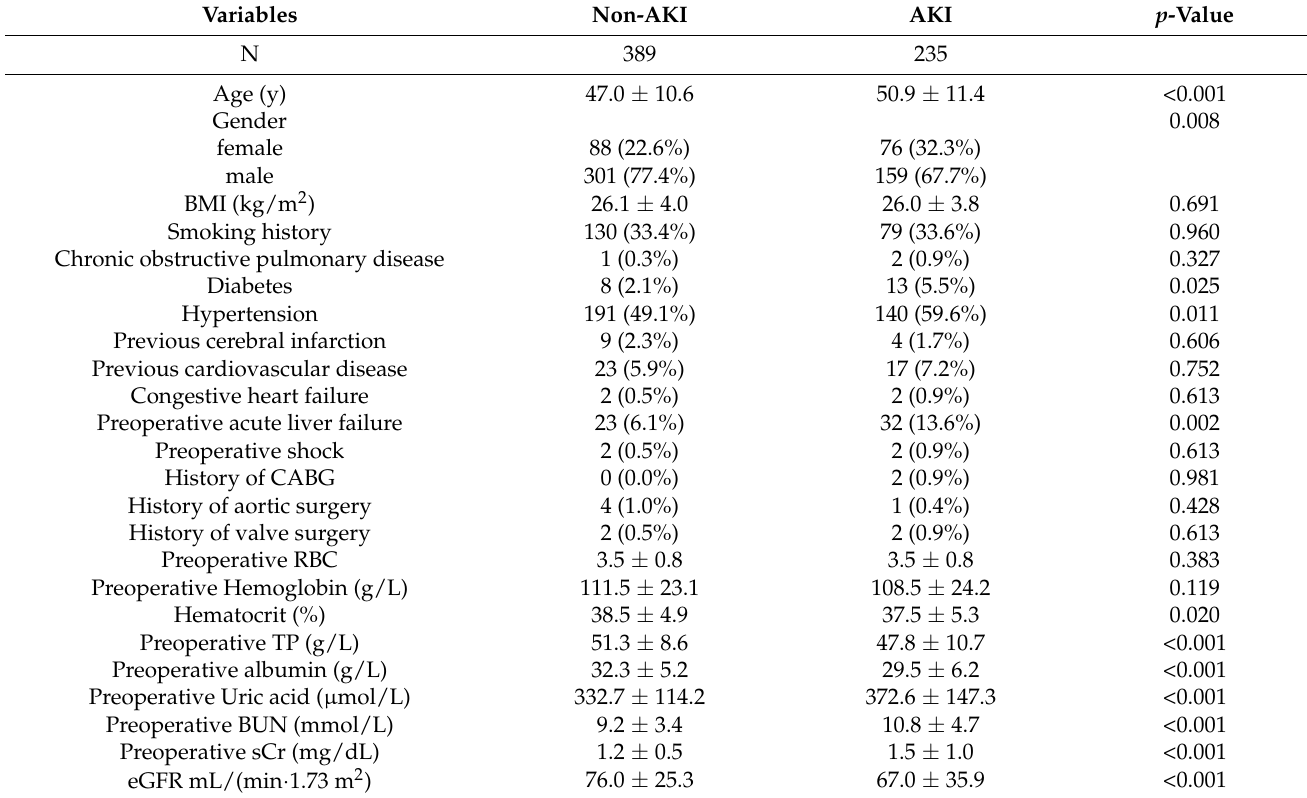
Table 1. Characteristics of study patients at